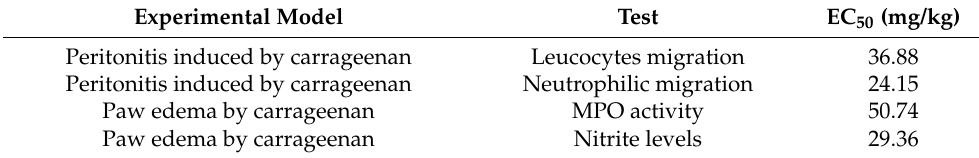
Table 1. EC 50 values of essential oil of Hyptis crenata on mediators of inflammation. (n 1 = 8–10). Experimental